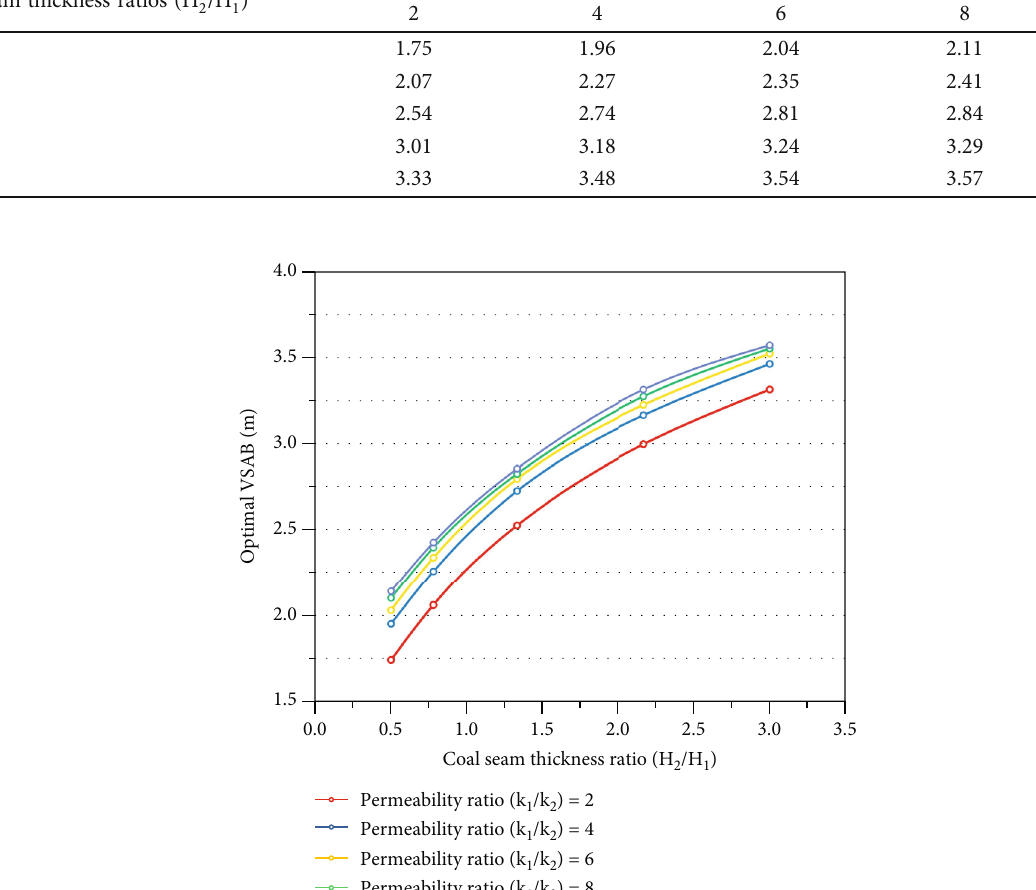
Figure 9: Relationship between optimal VSAB and coal seam thickness ratio ( H